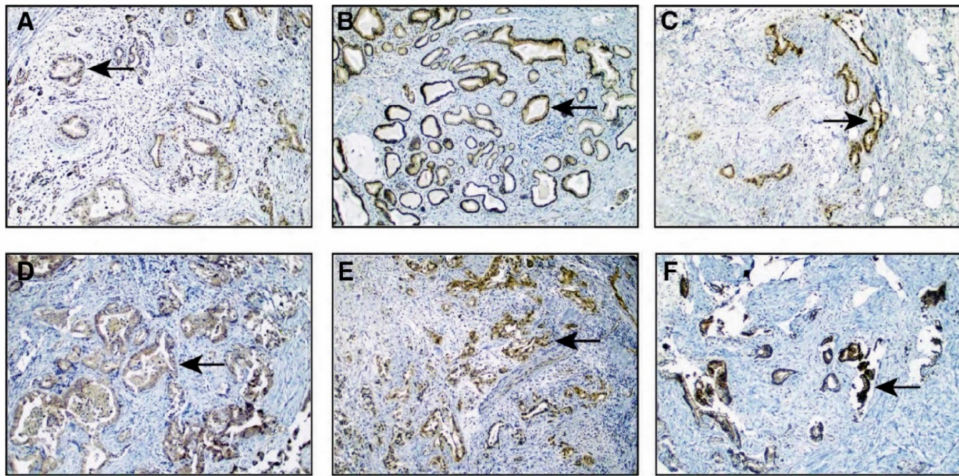
Figure 7. EphB4 immunostaining of pancreatic ductal adenocarcinoma. The panel shows a magnified view (200 × ) of infiltrating tumor regions in representative cores from tissue microarrays. The photomicrographs are ordered with increasing EphB4 expression (from ( A – F )), as evidenced by the intensity of brown color development using anti-EphB4 antibody-based immunostaining shown by